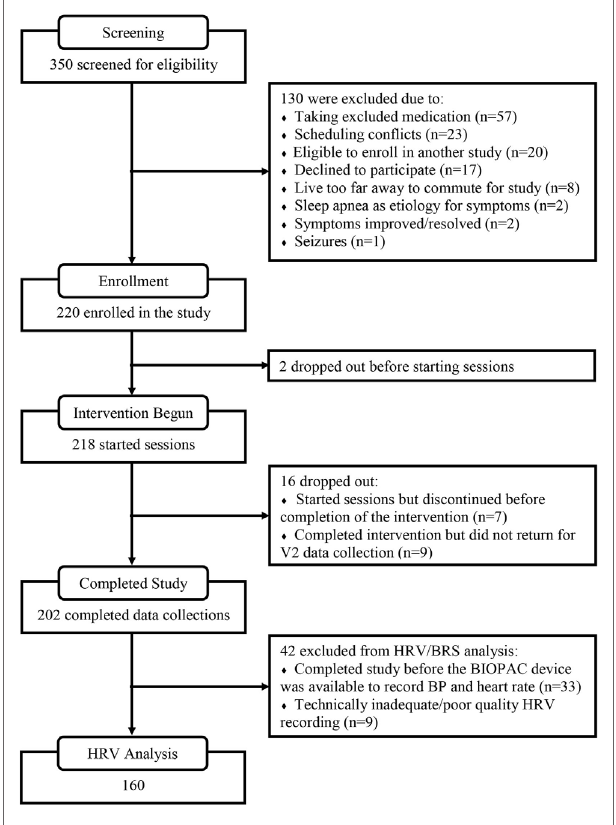
FigUre 1 | Study participant